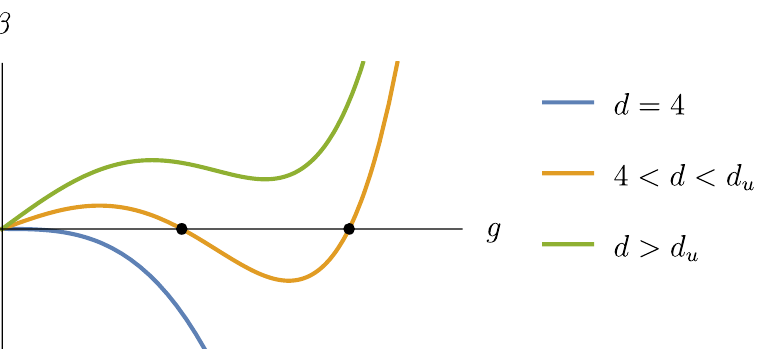
Figure 2. Conjectured behavior of the beta function of the Yang–Mills coupling in various dimensions d , for which the slope at g = 0 is proportional to (cid:101) = d − 4. The blue function is the asymptotically free beta function of standard four dimensional Yang–Mills. For an interval of dimensions between the critical value, d = 4, and a speculative upper critical value, d u , the model admits two nontrivial fixed points, which are highlighted with dots in the figure. One is of ultraviolet nature, while the other one is infrared and assumed to be associated to a multicritical theory in the main text. Any change in d corresponds to a change in the initial slope of the beta function, so at d = d u the two fixed points collide and above d u the curve is not able to intercept the horizontal axis any longer